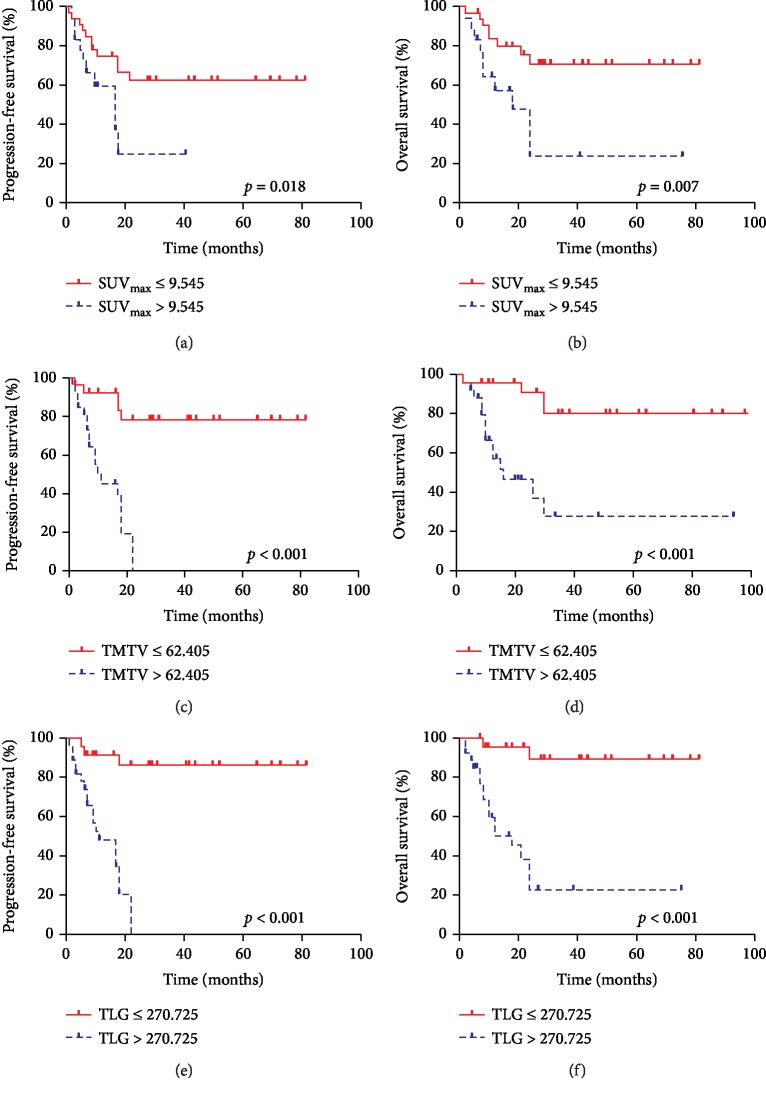
Kaplan-Meier survival analysis of PFS and OS in PTCL patient according to (a, b) SUVmax, (c, d) TMTV, and (e, f) TLG.